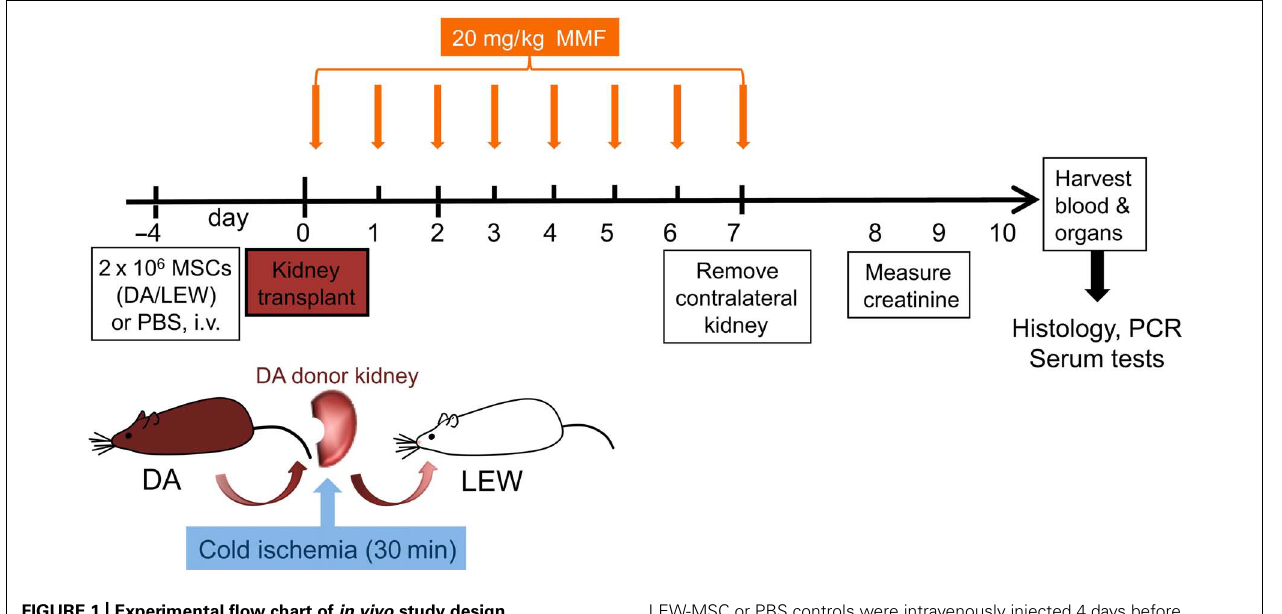
FIGURE 1 | Experimental flow chart of in vivo study design. DA (DA, RT1 av ) kidneys were harvested, perfused with UW solution and kept at 4 ◦ C before being transplanted orthotopically into Lewis (LEW, RT1A l ) recipients. MMF treatment was given daily from day 0 to 7 at a dosage of 20 mg/kg body weight.Two million donor-type DA-MSC or recipient-type